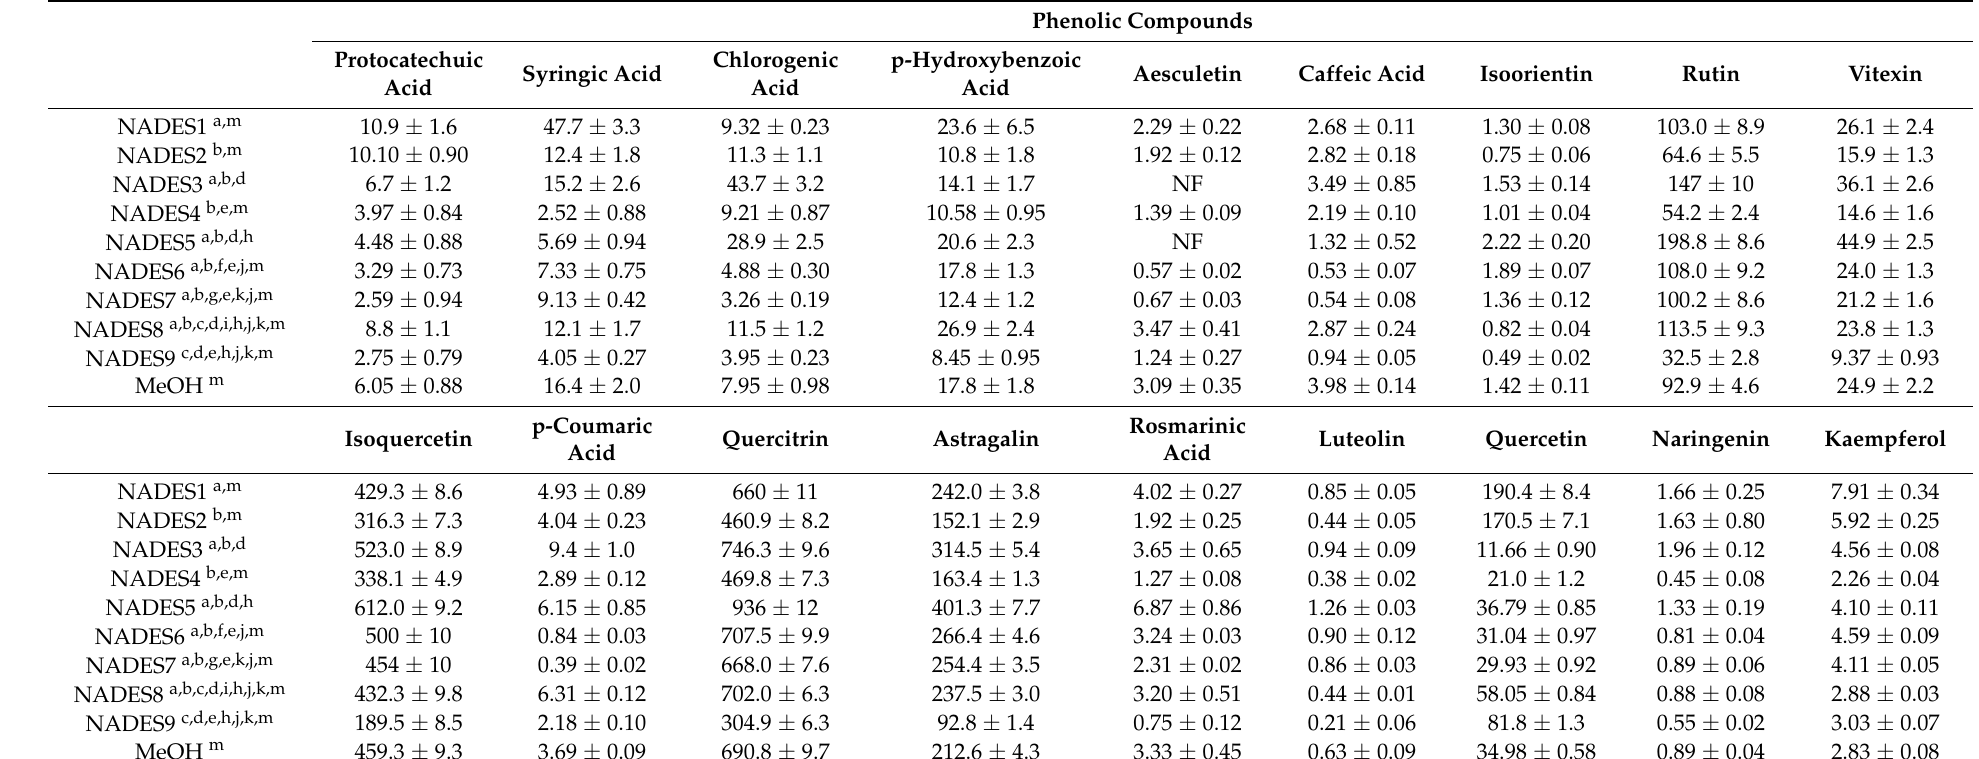
Table 2. Phenolic compounds quantified in A. eupatoria (mg/kg of dried sample)